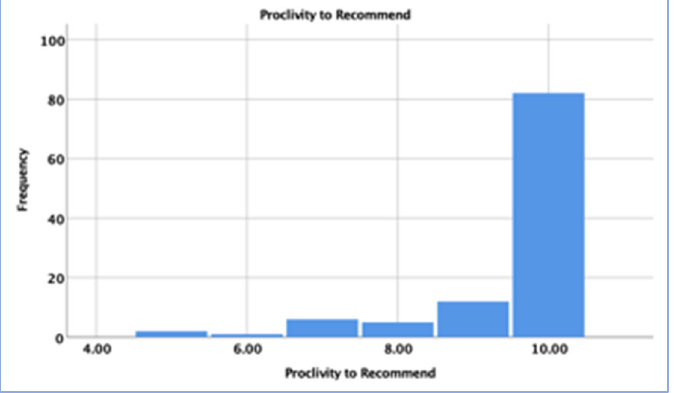
Figure 5. Distribution of Proclivity to Recommend